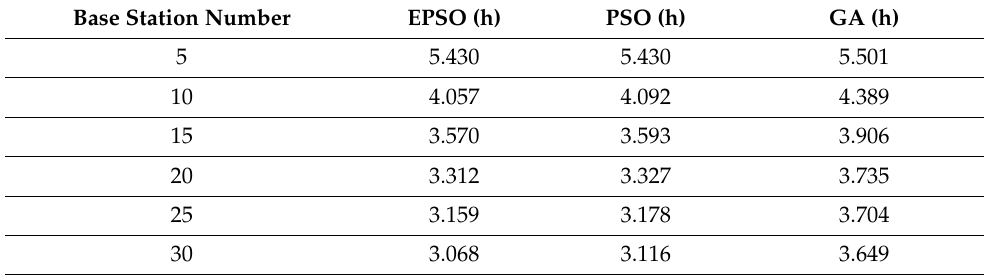
Table 2. Rescue time distributions for different models under varied ship base station